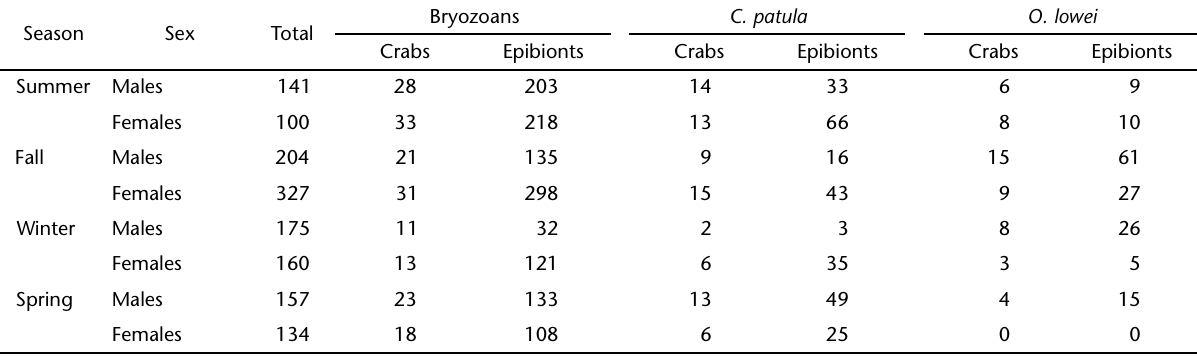
Table I. Arenaeus cribrarius . Total number of mature crabs infested by epibionts in each season from the specimens collected in Ubatuba (São Paulo), from May/1991 to April/1993. (Total) Total number of crabs collected in each category, (Crabs) total of crabs infested, (Epibionts) total number of individuals or colonies of epibionts.